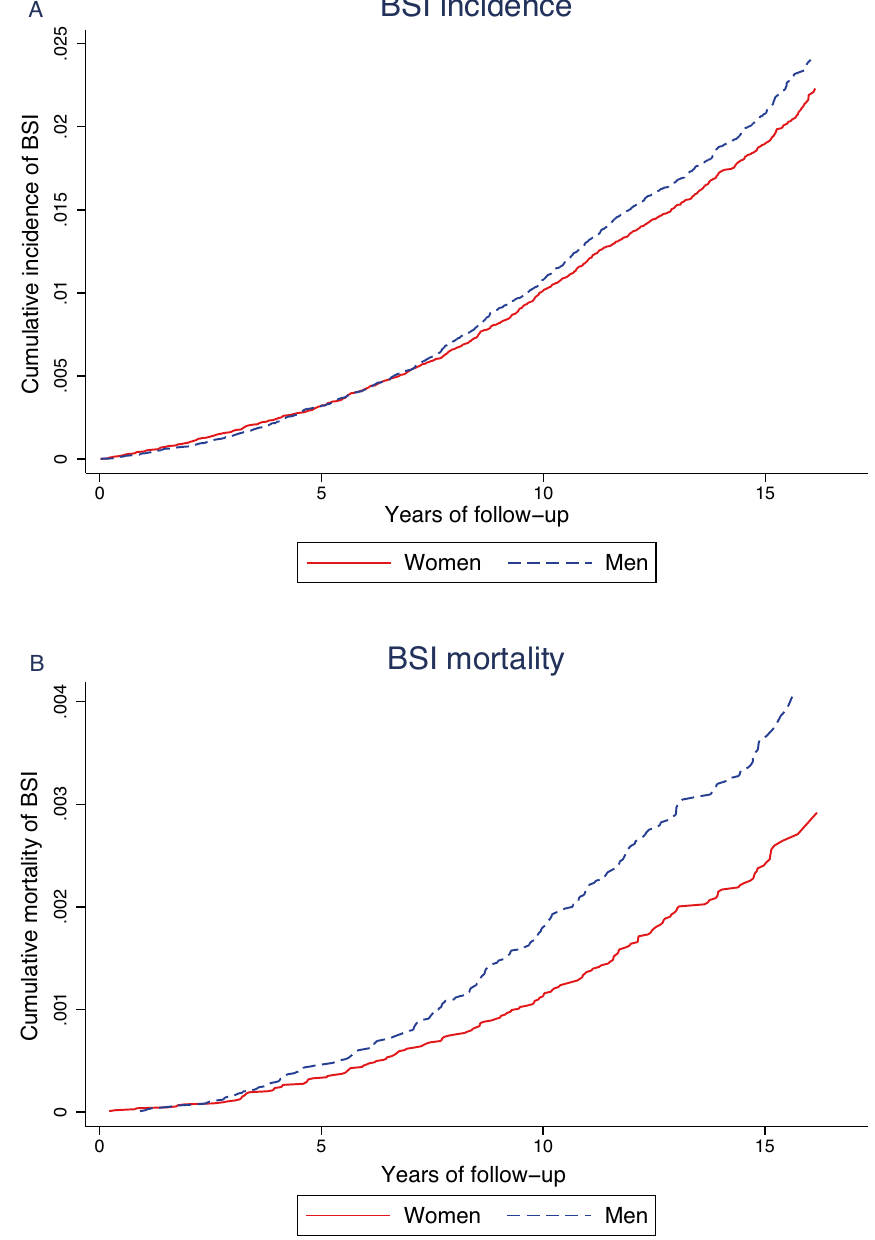
Figure 2. Sex differences in cumulative incidence and mortality of BSI. Age-adjusted sex difference in cumulative incidence of BSI ( A ), and in cumulative mortality ( B ), estimated for age 49.99 (the mean age of the total population). Note: due to the variation in incidence of different outcomes the scale of the Y-axis is not uniform across the